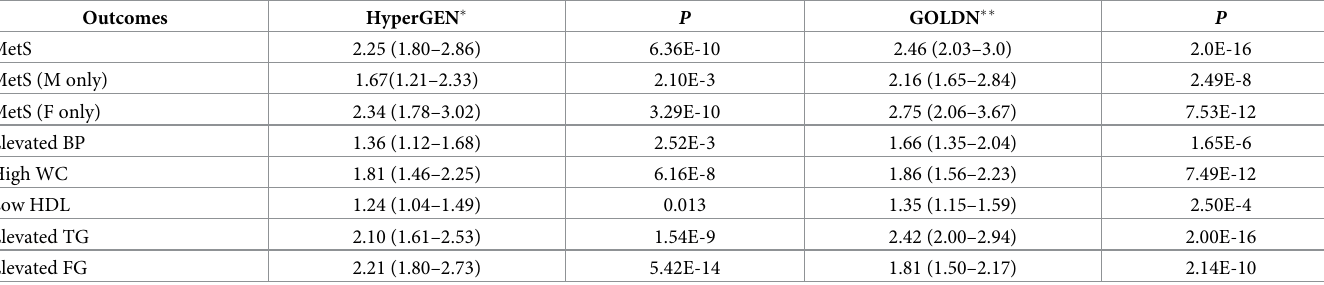
Table 4. Cohort-specific association of the Methylation Risk Score (MRS) with MetS and MetS components.